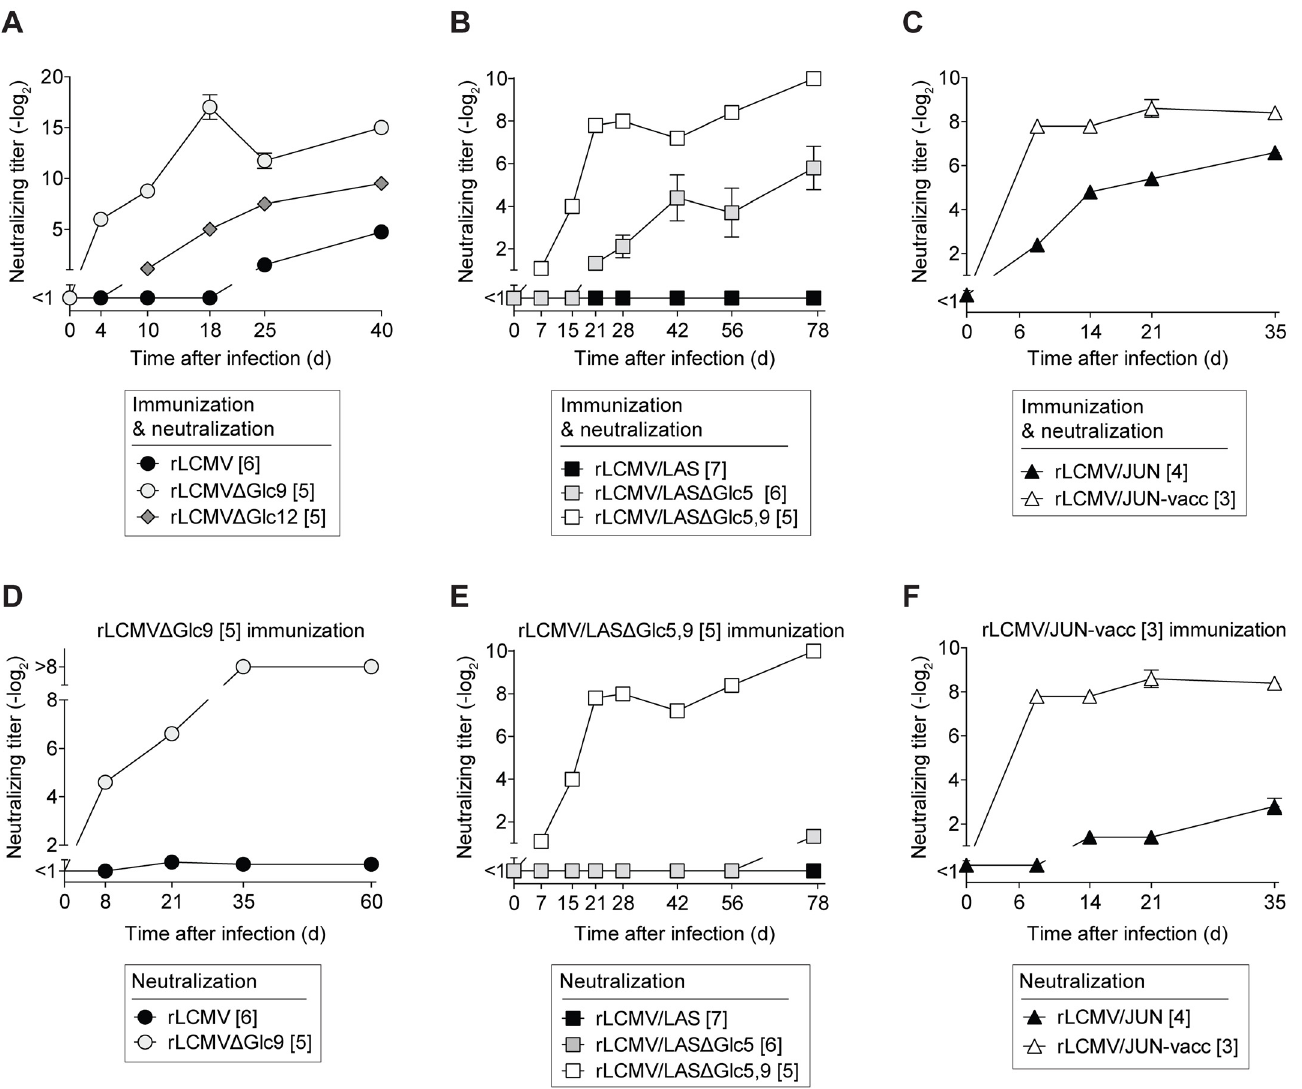
Fig 2. Viral variants lacking select GP-1 glycans elicit a potent but largely variant-specific nAb response. We infected C57BL/6 mice with the indicated viruses and variants expressing partially glycan-deficient GP versions and determined neutralizing serum activity against the immunizing virus (A-C) or against heterologous virus in comparison to the immunizing virus (D-F), as indicated. Doses of 4x10 6 PFU (A), 5x10 5 PFU (B, E) or 2x10 5 PFU (C, D, F) were given as a single i.v. injection on day 0. For each virus, the number of GP-1 N-linked glycosylation motifs on GP-1 of each virus ’ GP is indicated in brackets. Symbols represent the mean ± SEM of four to five mice per group. One of two similar experiments is shown. Neutralizing titers were determined in 12.5-fold (A), 10-fold (B-C, E-F) or 8-fold (D) pre-diluted